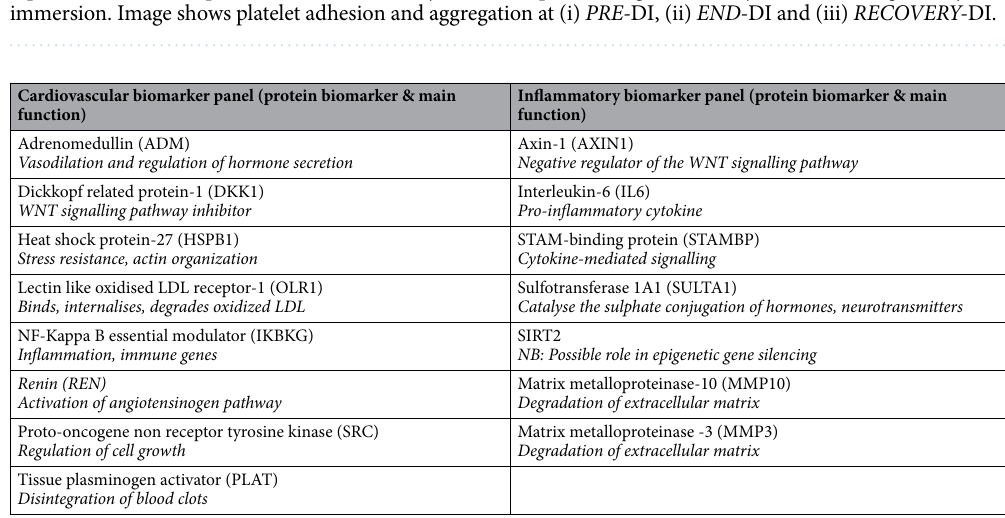
Figure 3. ( A ) Effect of dry immersion on platelet function assessed by Impact R analysis. Graphs represent the mean ± SEM of each parameter at each time point. (i) Platelet Adhesion and (ii) Platelet Aggregation. * P < 0.05. Paired samples t-test and repeated measures ANOVA (adjusted for age, BMI and VO 2; n = 12 biological replicates, technical replicates n = 3 for each subject). ( B ) Impact R images from subject J at each stage of dry immersion. Image shows platelet adhesion and aggregation at (i) PRE- DI, (ii) END- DI and (iii) RECOVERY- DI.